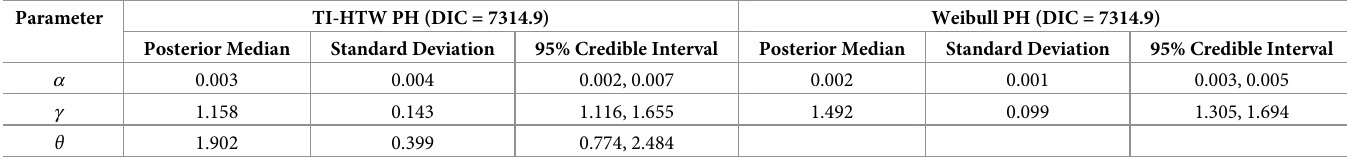
Table 13. Bayesian analysis of the TI-HTW and Weibull